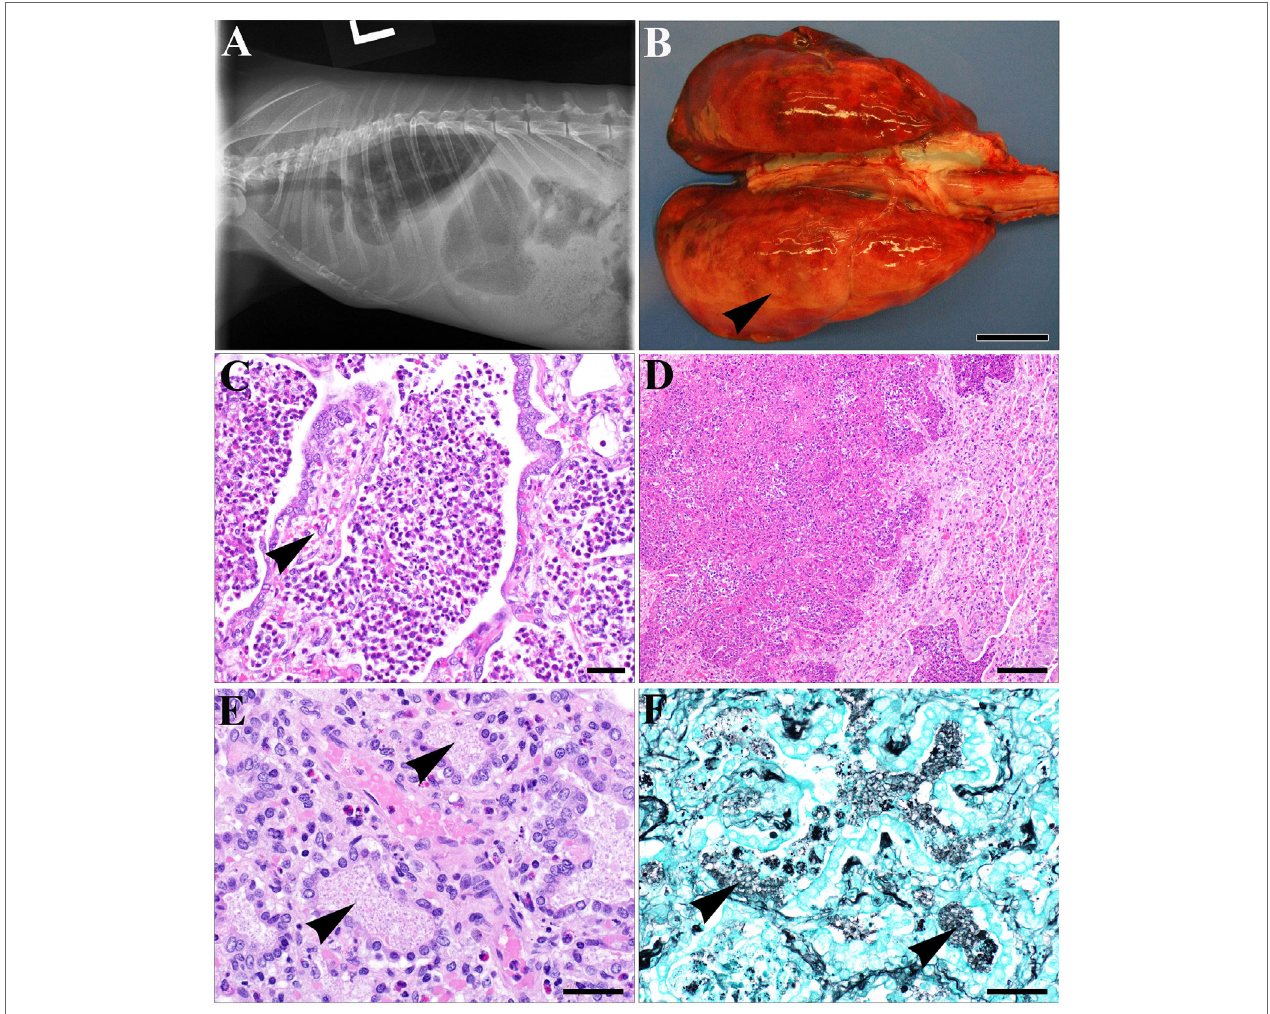
FigUre 3 | Gross pathology and histopathology of knockout rabbits with pneumonia. ( a) Left lateral thoracic radiograph of a severe combined immunodeficiency rabbit (#725) with pleural effusion. A soft tissue opacity was observed in both the caudal and ventral thoracic cavity, obscuring the cardiac silhouette and causing dorsal retraction of the lung fields. The radiographic appearance is consistent with pleural effusion. (B) Lungs of affected animals were diffusely expanded, variably mottled dark red to tan, often containing lateral rib impressions (arrowhead). Bar = 1 cm. (c) Marked inflammatory cell infiltrate centered on bronchioles and alveoli composed of heterophils, fewer macrophages and cellular debris, with denudation of bronchiolar epithelium and partial filling of bronchiolar lumens with granulation tissue (arrowhead). Bar = 20 μ m. (D) Multifocal to coalescing zones of alveolar wall necrosis and filling with degenerate heterophils and cellular debris, with atelectasis of adjacent pulmonary parenchyma. Bar = 50 μ m. (e) Alveolar spaces are lined by type II pneumocyte hyperplasia and filled with faintly eosinophilic, foamy material (arrowheads). Bar = 20 μ m. (F) Gomori methenamine silver staining of lung tissue demonstrating clusters of Pneumocystis cysts (arrowheads) within alveolar spaces. Bar = 20 μ m. Representative individual results and images are from animal #196 unless otherwise